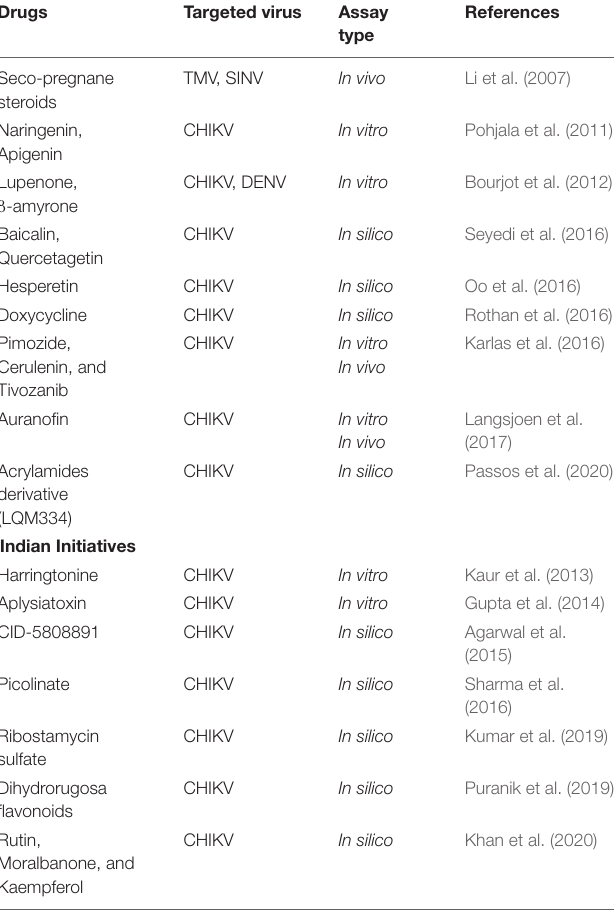
TABLE 5 | List of suggested novel antivirals and repurposing initiatives against CHIKV.